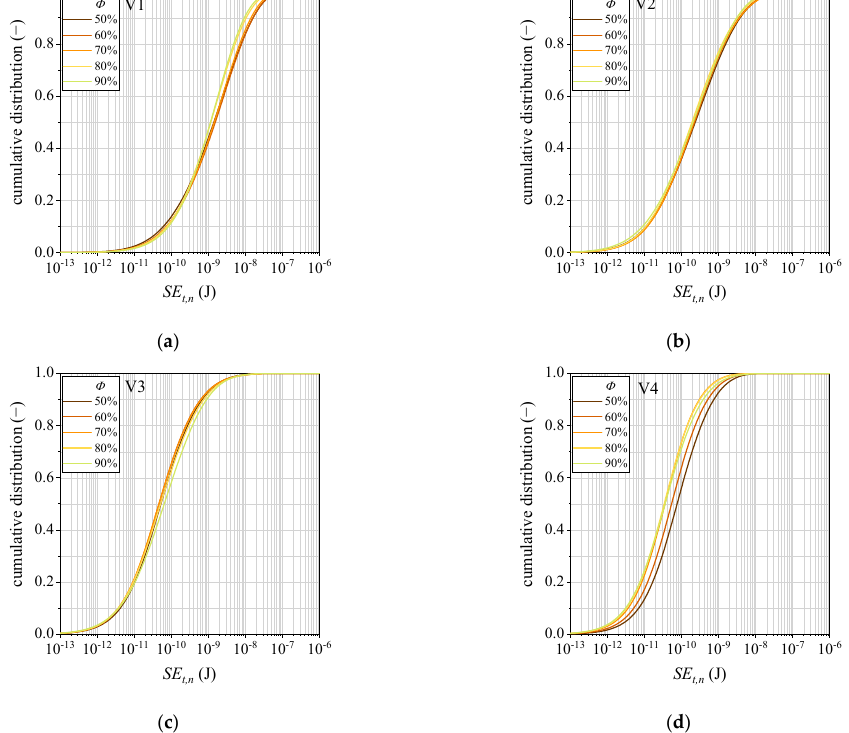
Figure A2. Stress energy distribution for the trans-normal direction at varied grinding media fillings and stirrer speed of 6 m/s in ( a ) V1, ( b ) V2, ( c ) V3, and ( d ) V4.